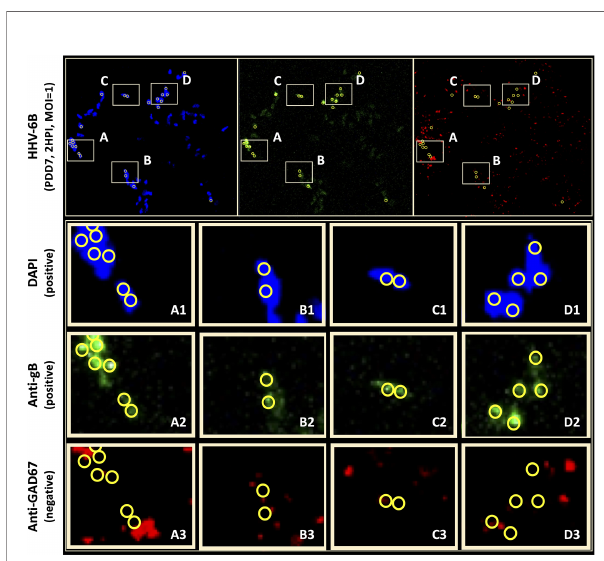
FIGURE 9 | Anti-gB/DAPI fl uorescence does not colocalize with GAD67- positive cells in mixed cultures. DAPI microscopy images of immuno fl uorescence and fl uorescence staining of dHNSC at PDD7, MOI = 1, 2HPI challenged with HHV-6B. Out of multiple trials, only one anti-GAD67 positive culture displayed an anti-gB fl uorescence signal indicating possible infection of GABA-containing neurons ( top ). However, upon closer examination of anti-gB cell clusters (regions A-D), it appears that DAPI positive cells (rows A1-D1) and anti-gB positive (rows A2-D2) cells are anti- GAD67 negative (row A3-D3) providing further evidence for GABAergic neuron resistance to HHV-6 infection. DAPI/anti-gB positive fl uorescence is likely from adjacent glial cells or other neuronal neurotransmitter phenotypes in the mixed culture.